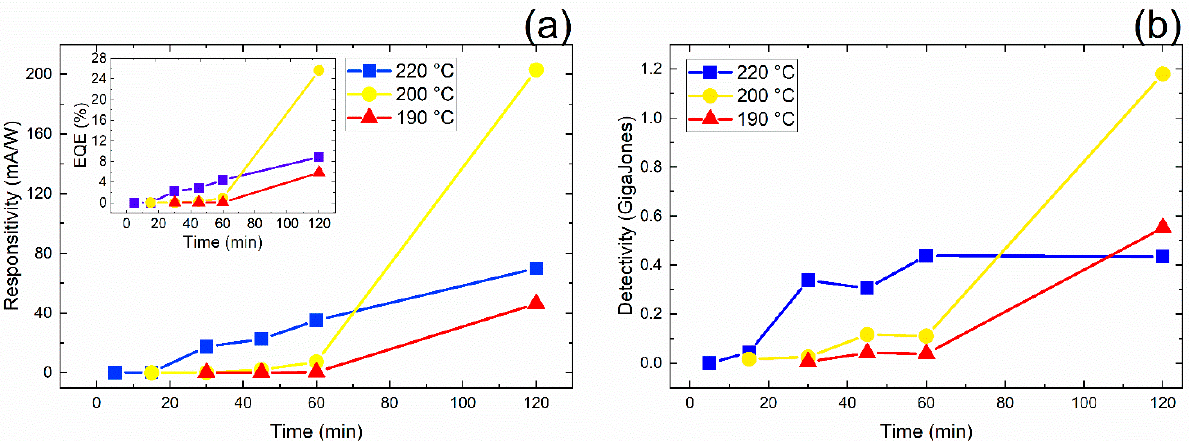
Figure 6. The Responsivity ( a ) and Detectivity ( b ) according to the synthesis time, for samples synthesized with temperatures of 190 °C (red triangles), 200 °C (yellow circles) and 220 °C (blue squares). Responsivity was measured with a laser power of 20 mW. Graph’s inset shows the external quantum efficiency (EQE) values as a function of time and synthesis temperatures of the MoS 2 photoactive layer.